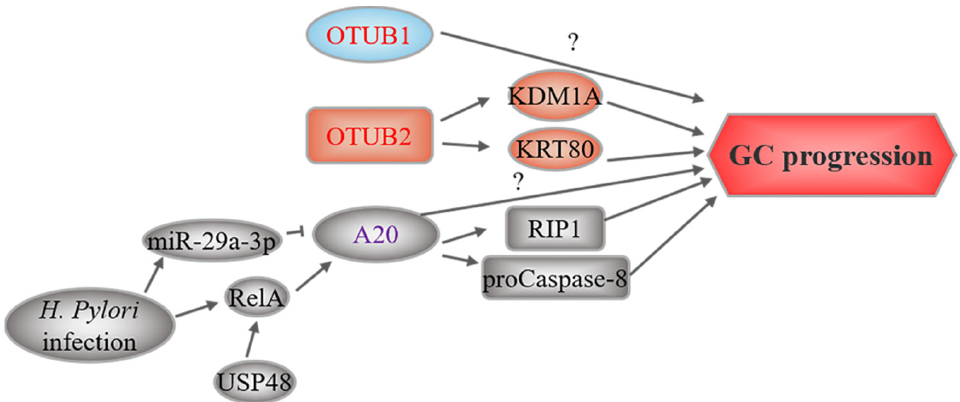
Figure 4. OTU-related upstream regulation and downstream mechanisms in GC. OTUs marked in red represent oncoproteins, while purple-labeled OTUs play a dual role. The text to the left and right of the OTUs corresponds to the upstream regulatory events and downstream substrates, re- spectively.